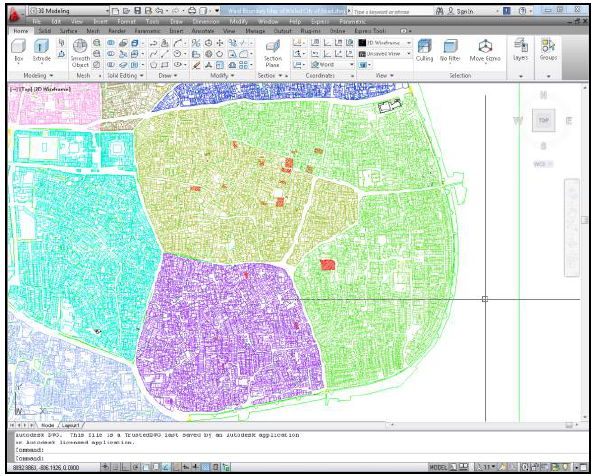
Figure 2. Digital map with heritage buildings for the study area